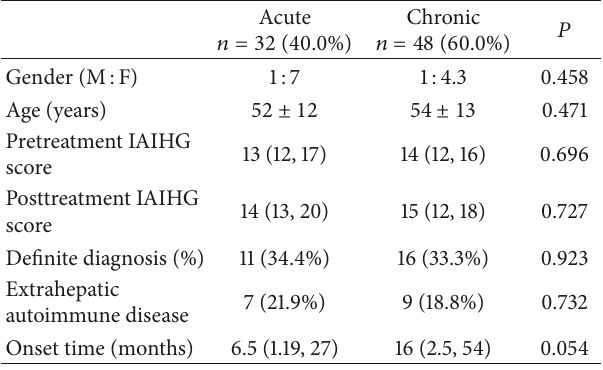
Table 1: Comparison of basic pieces of information between A-AIH and C-AIH